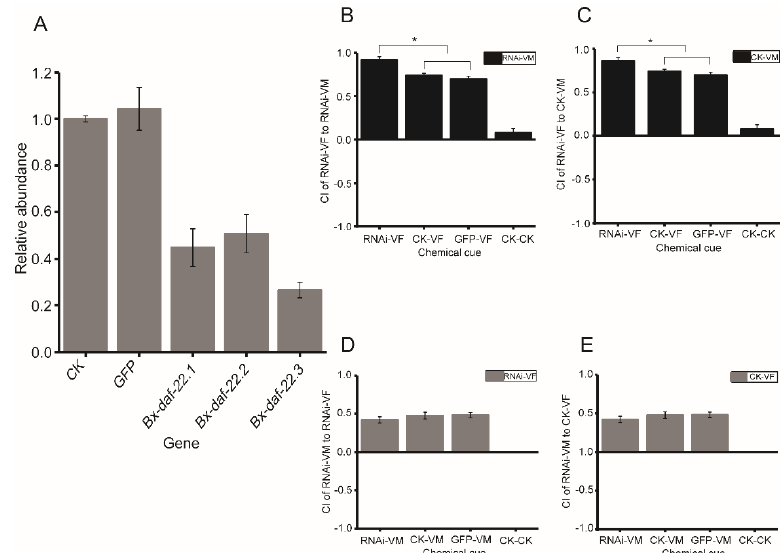
Figure 5. Expression levels of Bx-daf-22 genes and effects of male and female secretions on the opposite sex after RNAi of all three Bx-daf-22 genes. ( A ) Transcript abundance of Bx-daf-22.1, Bx-daf-22.2 , and Bx-daf-22.3 after the nematodes were treated with dsRNA of the three genes simultaneously for 36 h. ( B , C ) Attractiveness of secretions from RNAi-treated females to RNAi-treated and control males. ( D , E ) Attractiveness of secretions from RNAi-treated males to RNAi-treated and control females. CK: the positive control, nematodes treated with the M9 bu ff er alone. GFP: the negative control, nematodes treated with dsRNA of gfp . Bx-daf-22.1, Bx-daf-22.2 and Bx-daf-22.3 : The relative abundance of each gene after nematodes treated with dsRNA of Bx-daf-22.1 , Bx-daf-22.2, and Bx-daf-22.3 simultaneously. RNAi-VF / RNAi-VM: virgin female / male treated with dsRNA of three Bx-daf-22 genes. CK-VF / CK-VM: virgin female / male treated with M9 alone. GFP-VF / VM: virgin female / male treated with dsRNA of gfp . CK–CK: the negative control, chemotaxis assay use ddH 2 O on the two spots. CI (chemotaxis index) = ((number of nematodes at the test zone) − (number of nematodes at the control zone)) / total number of nematodes. VF: virgin female VM: virgin male. * p <